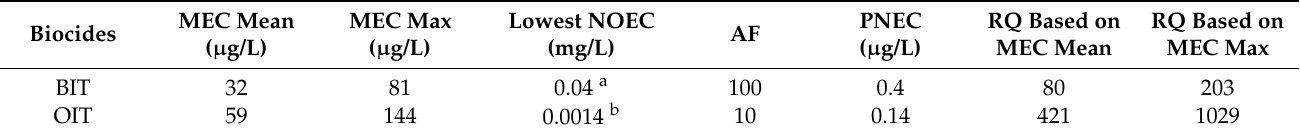
Table 3. RQs values derived from BIT and